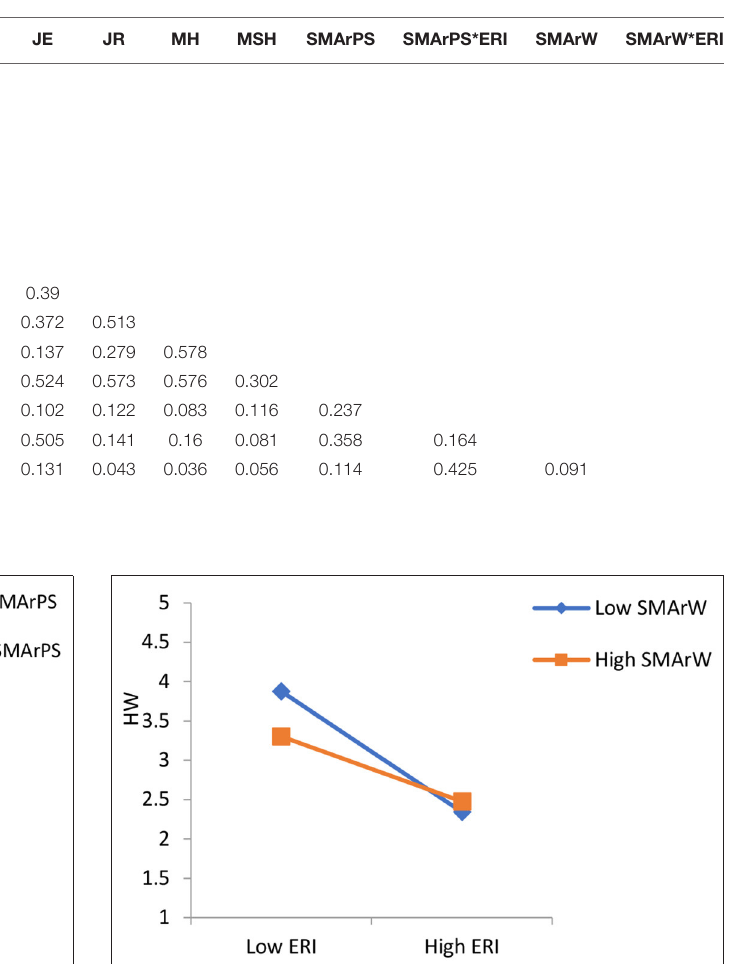
FIGURE 3 | The moderating effect of SMArW on the relationship between ERI and